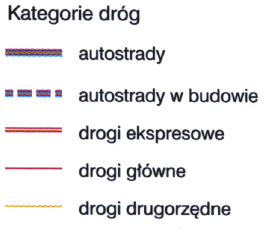
Fig. 9. Linear symbols used to show the categories of roads